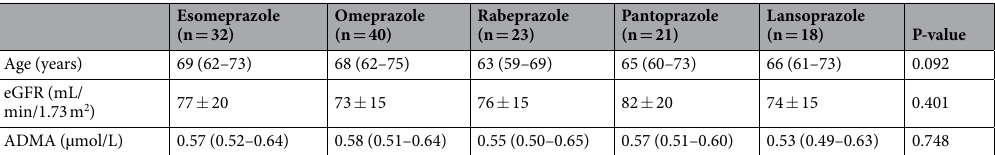
Table 4. Plasma asymmetric dimethylarginine concentrations in users of specific proton pump inhibitors e GFR: estimated glomerular filtration rate (Modification of Diet in Renal Disease formula); ADMA: asymmetric